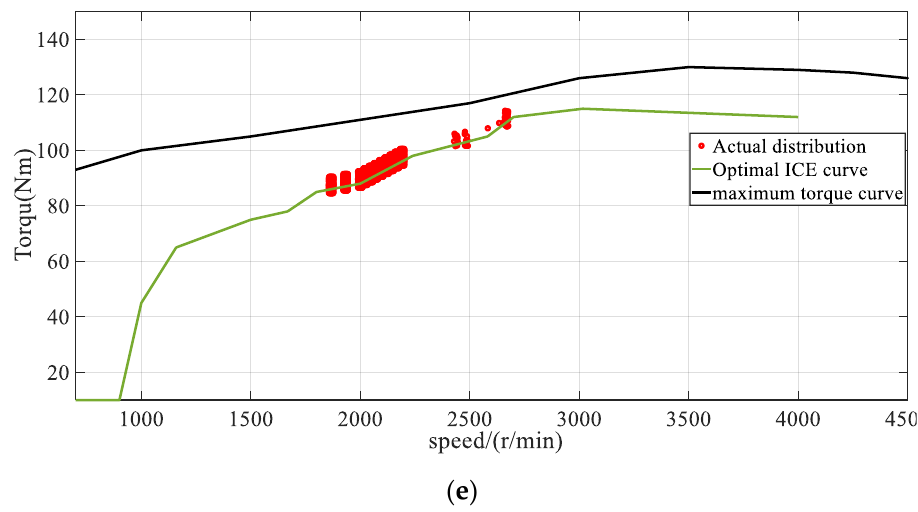
Figure 11. Braking performance in EMCB: ( a ) slip rate variation; ( b ) vehicle speed and wheel speed variation; ( c ) braking torque variation; ( d ) motor efficiency variation; ( e ) engine operating point.